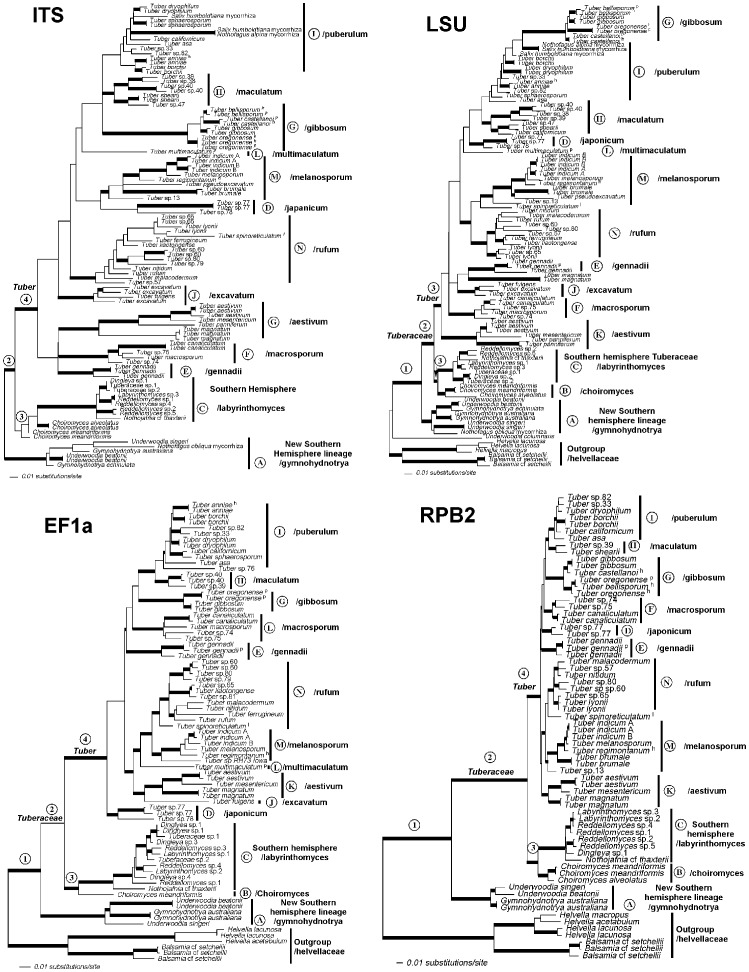
Phylogenetic reconstructions of Tuber based on maximum likelihood analysis of four individual loci: internal transcribed spacer region (ITS), 28
s large subunit rDNA (LSU), elongation factor 1-alpha (EF1a), and RNA polymerase II (RPB2). Models and likelihood scores for each locus are: ITS = Sym +G+I (–3960.627); LSU = GTR +G+I (−8732.114); EF1a = GTR +G+I (7374.012); RPB2 = K80 (5880.021). Clade names and node labels are consistent with each other and with figures 4 and 5. Taxa in the Helvellaceae were excluded from the ITS analysis because of the alignment challenges imposed by sequence divergence.